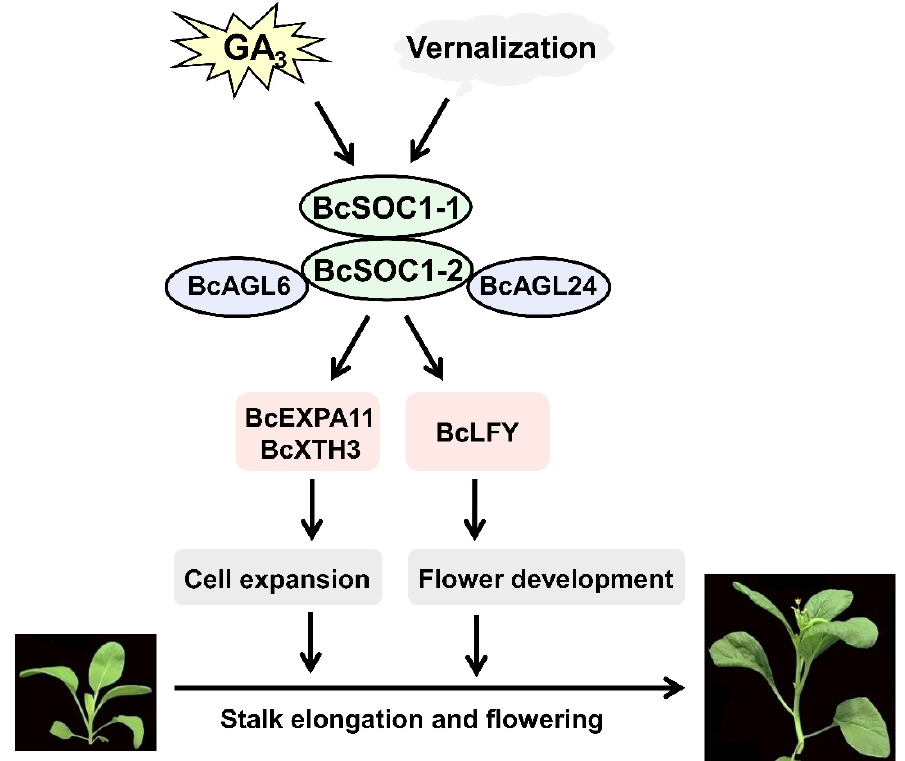
Figure 7. Model demonstrating GA 3 - and low temperature-induced bolting and stalk elongation in flowering Chinese cabbage. The arrow represents promotion.